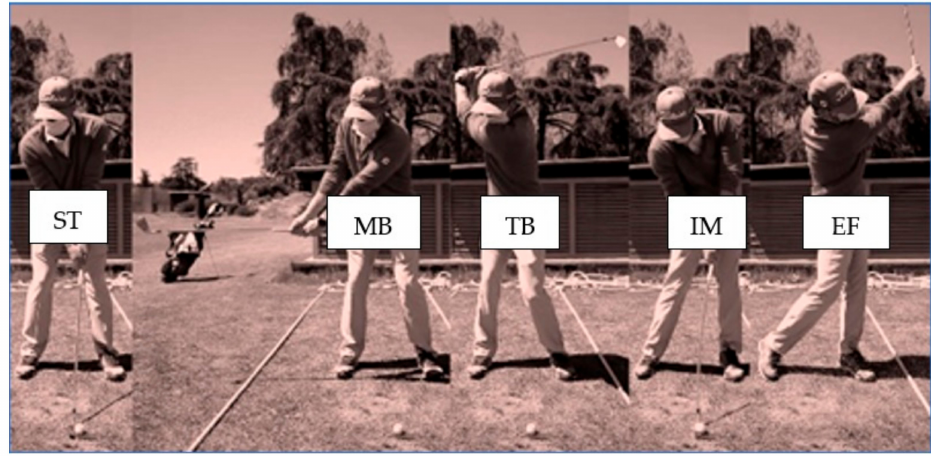
Figure 1. Key instants of the swing: Stand (ST), then the club start its movement; Middle Backswing (MB), when the club shaft is parallel to the ground; Top of backswing (TB), when the descent begins; Ball Impact (IM), when the club contacts the ball; Early finish (EF), when the saft surpasses the vertical axis to the